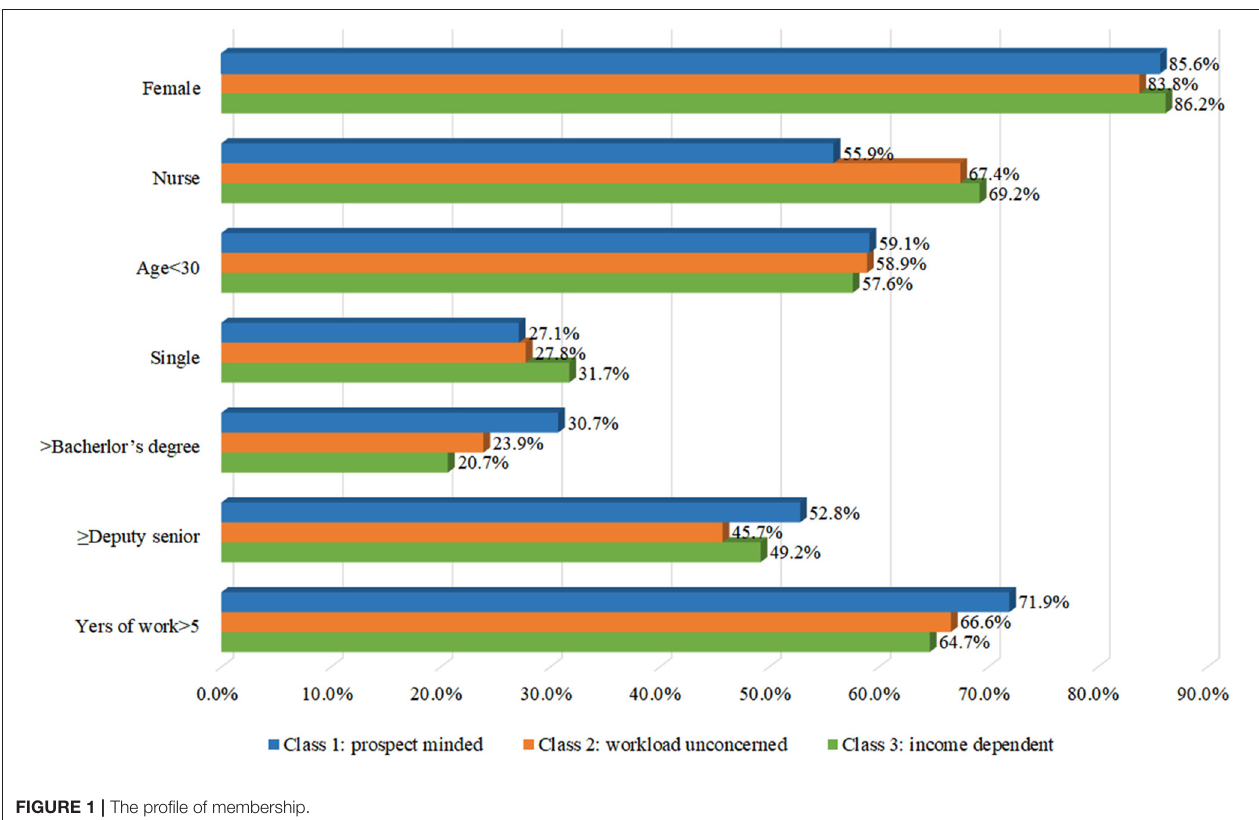
FIGURE 1 | The profile of membership.